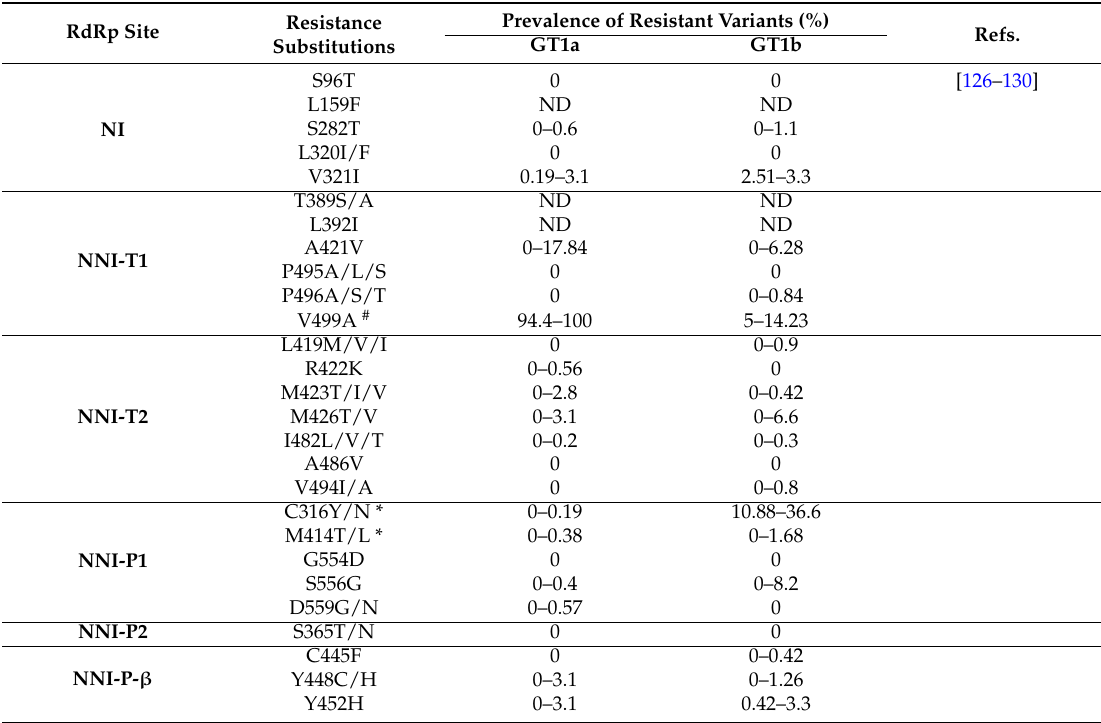
Table 1. Prevalence of known HCV RdRp variants associated with resistance to NI and NNIs in treatment naïve